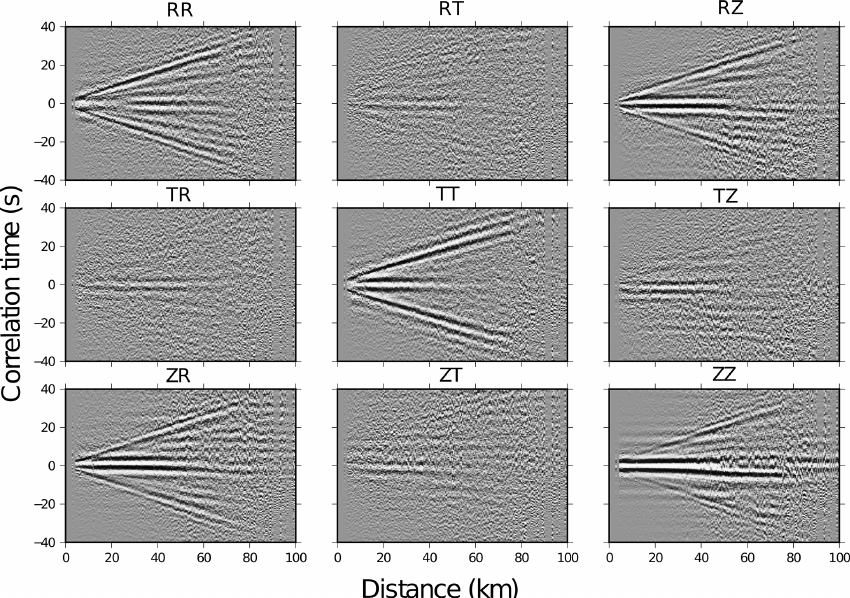
Figure 2. Record section of correlation functions calculated for inter-station paths of the DANA network. Correlation functions were filtered between 0.05 and 2.0Hz and binned and stacked in 0.5km distance bins, and the amplitude is normalized within each bin. Record sections for every combination of three-component motion are labelled as follows: Z – vertical, R – radial, T – transverse. The ZR correlation (bottom left) represents the motion recorded on the radial component due to a vertical point source. ZZ, ZR, RR and RZ components show Rayleigh waves, and TT shows Love